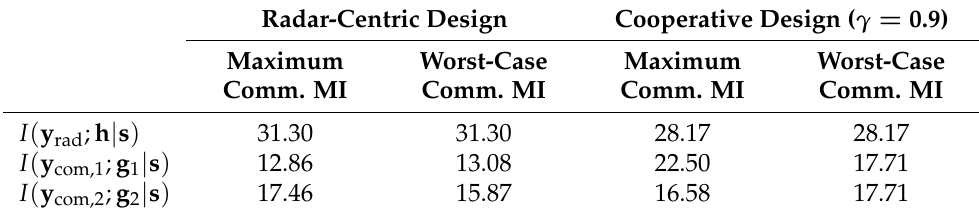
Table 2. Achieved mutual information for the proposed chunk-based